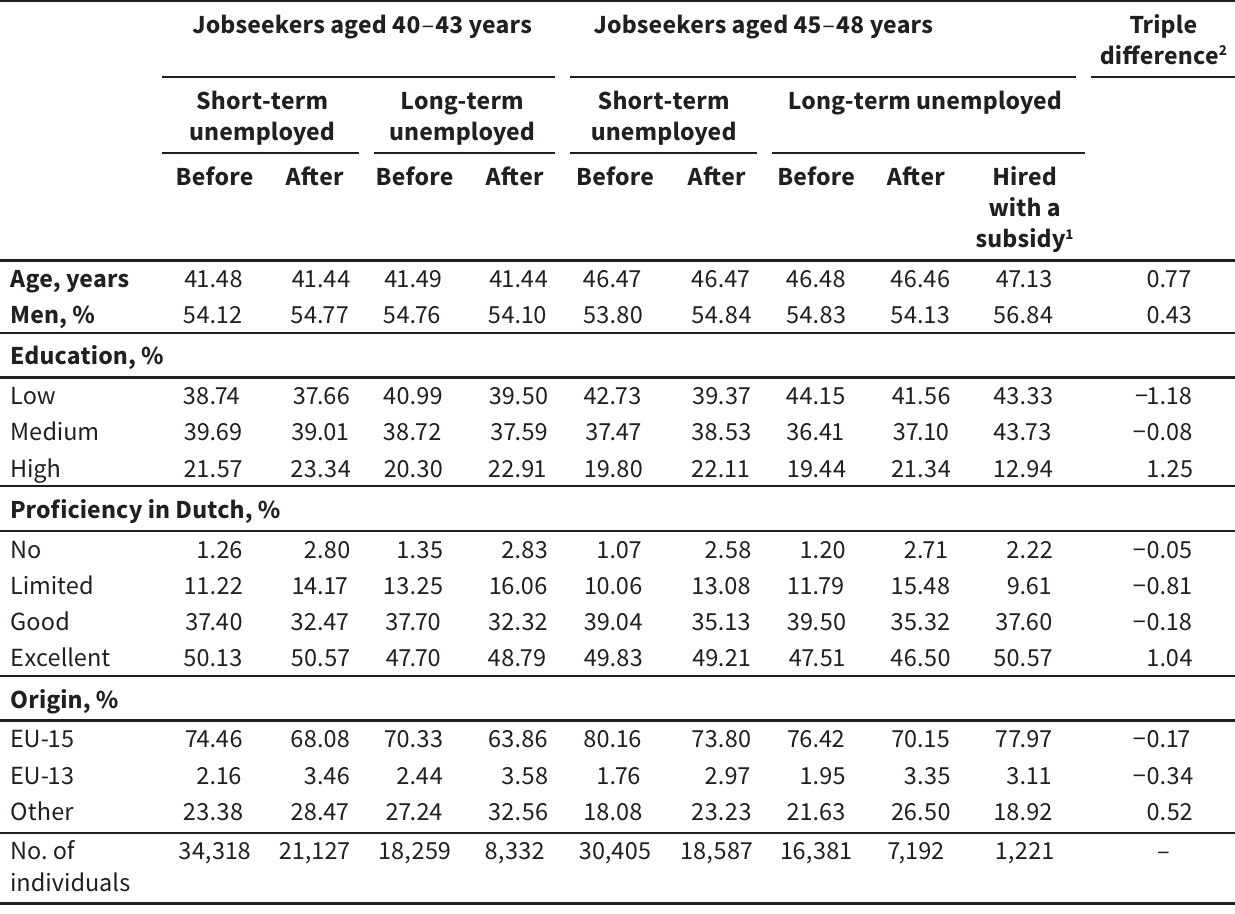
Characteristics of jobseekers by age group and unemployment duration: Age group; Unemployment duration, before and after the reform Jobseekers aged 40 – 43 years Jobseekers aged 45 – 48